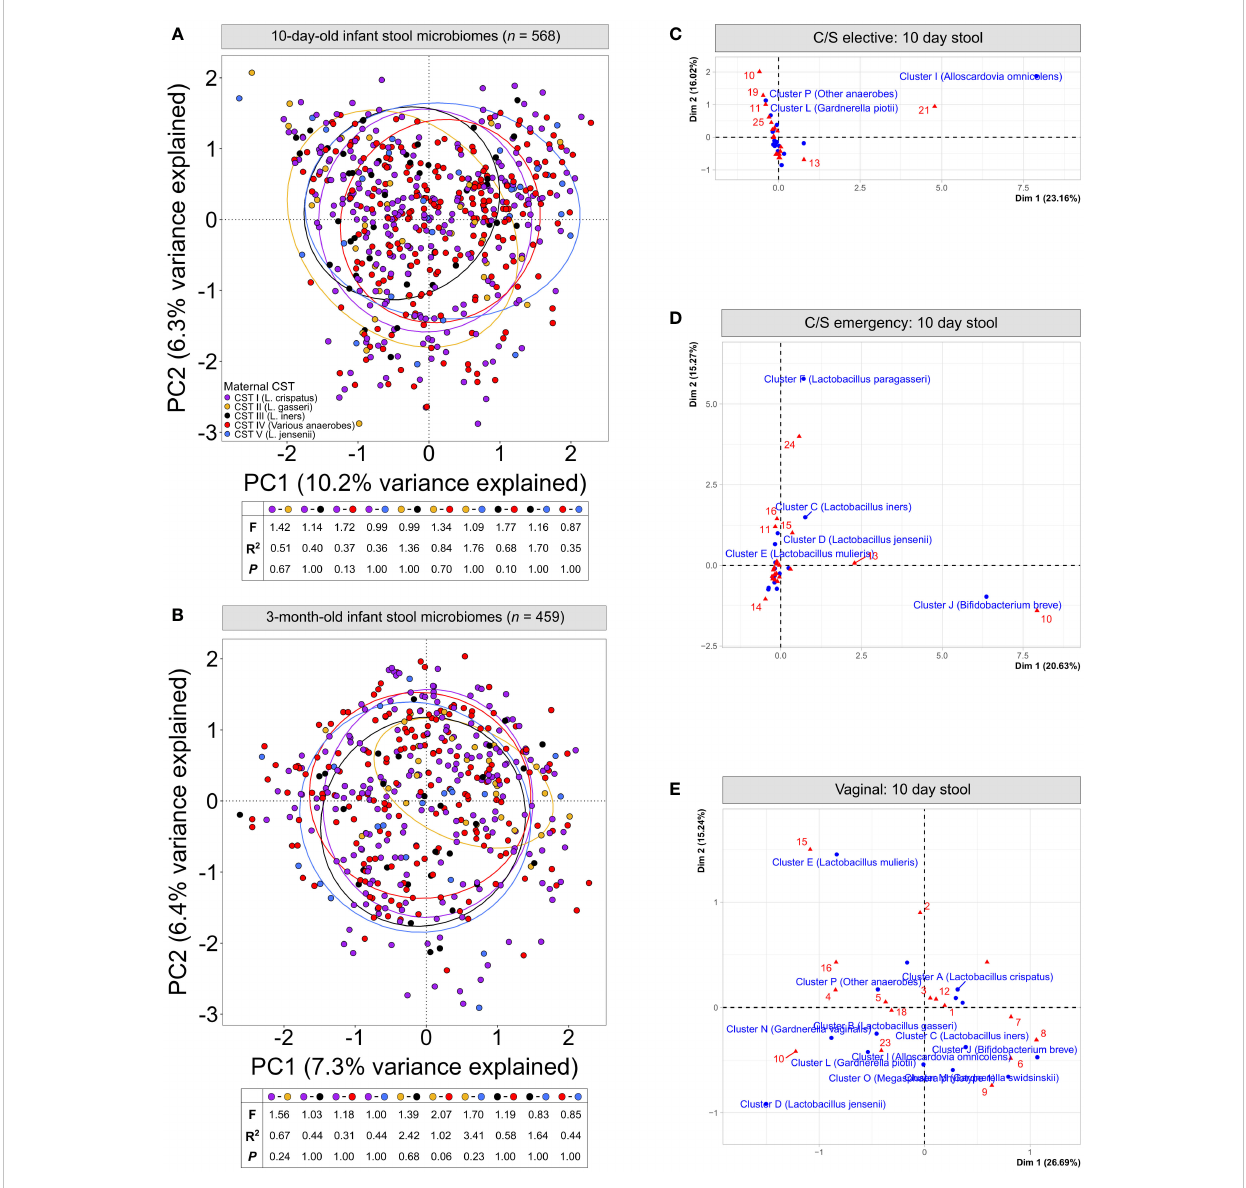
FIGURE 2 Infant stool microbiomes show no distinct clustering based on maternal vaginal CST: Principal component analysis of cpn60 stool microbiome pro fi les from 10-day (A) and 3-month (B) -old infants grouped by canonical maternal vaginal CSTs. No signi fi cant clustering was observed at 10-days (pairwise PERMANOVA, F = ¾1.77, R 2 = ¾1.76, P = ‗ 0.13) or 3-months (F = ¾2.07, R 2 = ¾3.41, P = ‗ 0.06). (C – E) Correspondence analysis of maternal vaginal CSTs (16 clusters) and infant stool clusters from 10-day-old infants, grouped by elective caesarean (C) , emergency caesarean (D) or vaginal delivery (E)